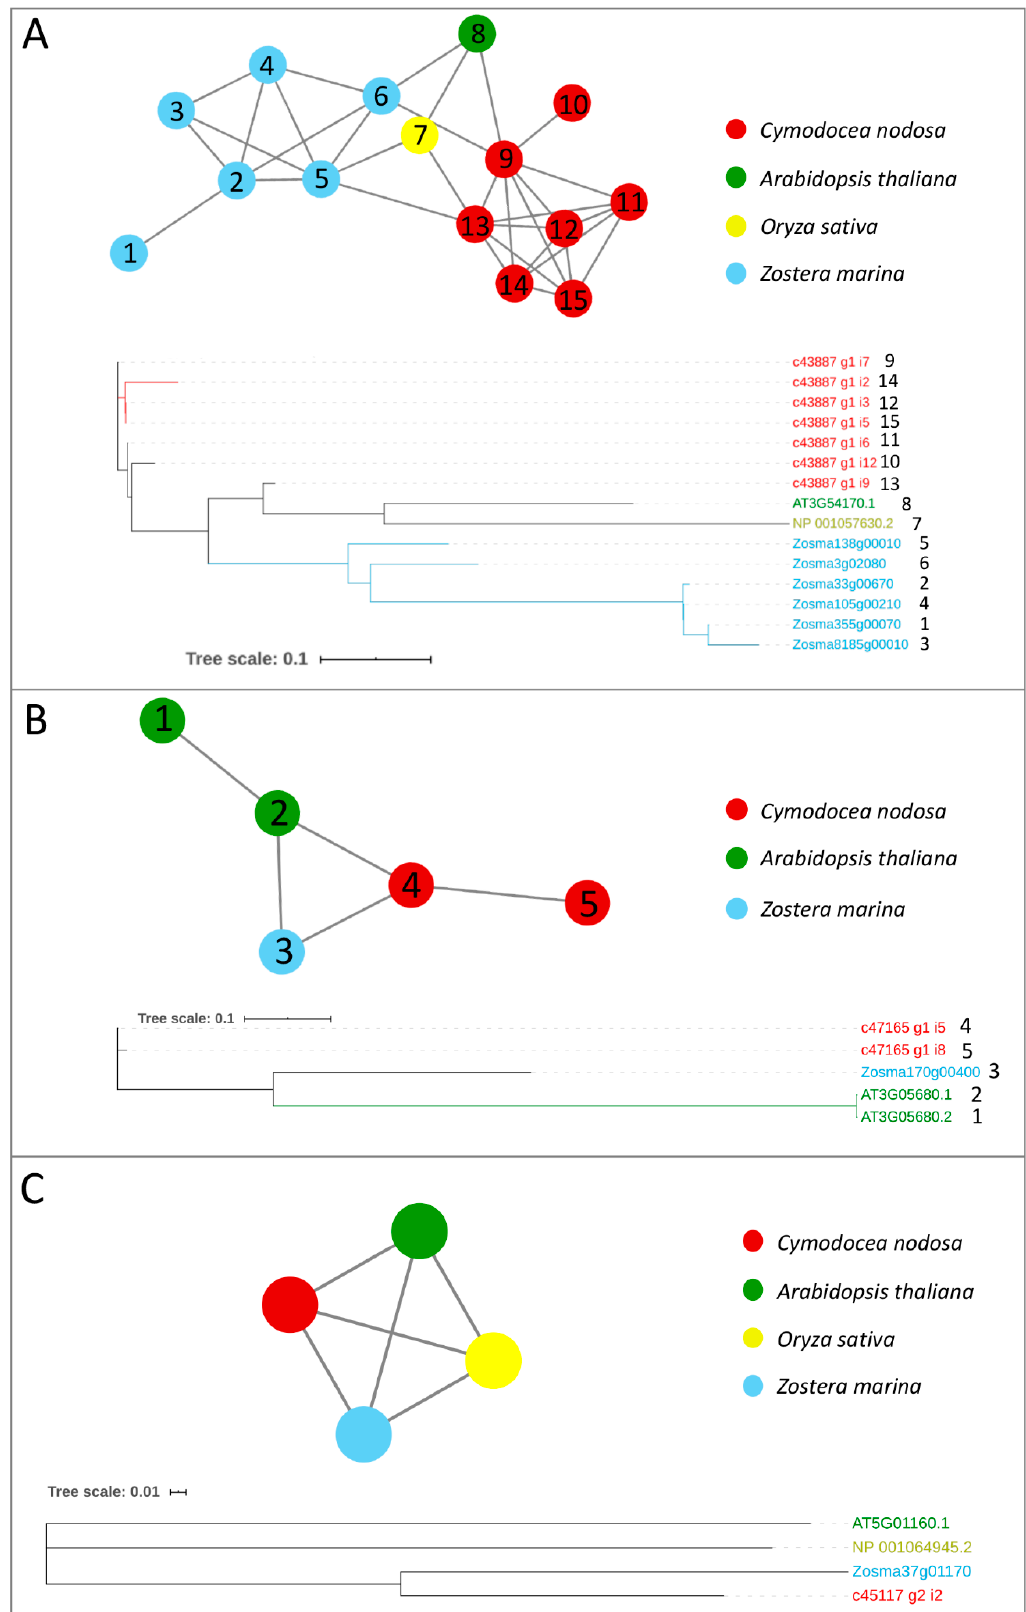
Figure 2. Orthologs / paralogs networks and phylogenetic trees of additional writers: ( A ) FIP37 (NET_2064); ( B ) VIRILIZER (NET_1791); and ( C ) HAKAI (NET_8223). Circles represent proteins per species, according to the legend. Grey lines represent homology relationships. Phylogenetic trees are constructed using an Approximately Maximum-Likelihood algorithm